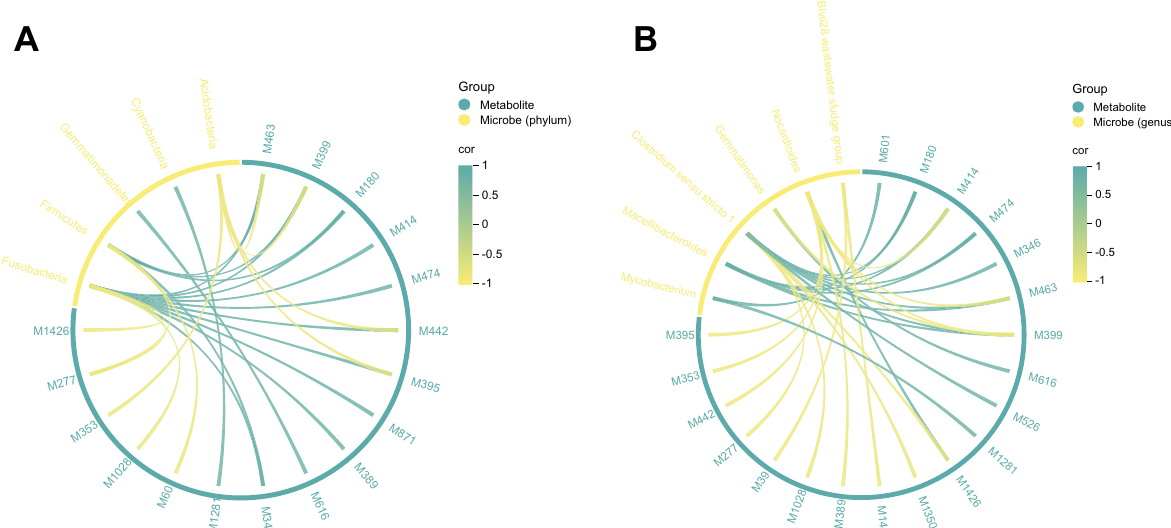
Fig. 4 The correlation of microbes and metabolites. A The correlation at the phylum level. B The correlation at the genus level. The lines in the circles represent the correlation between metabolites and microbes, with greener colours representing more positive correlations and yellower colours representing more negative